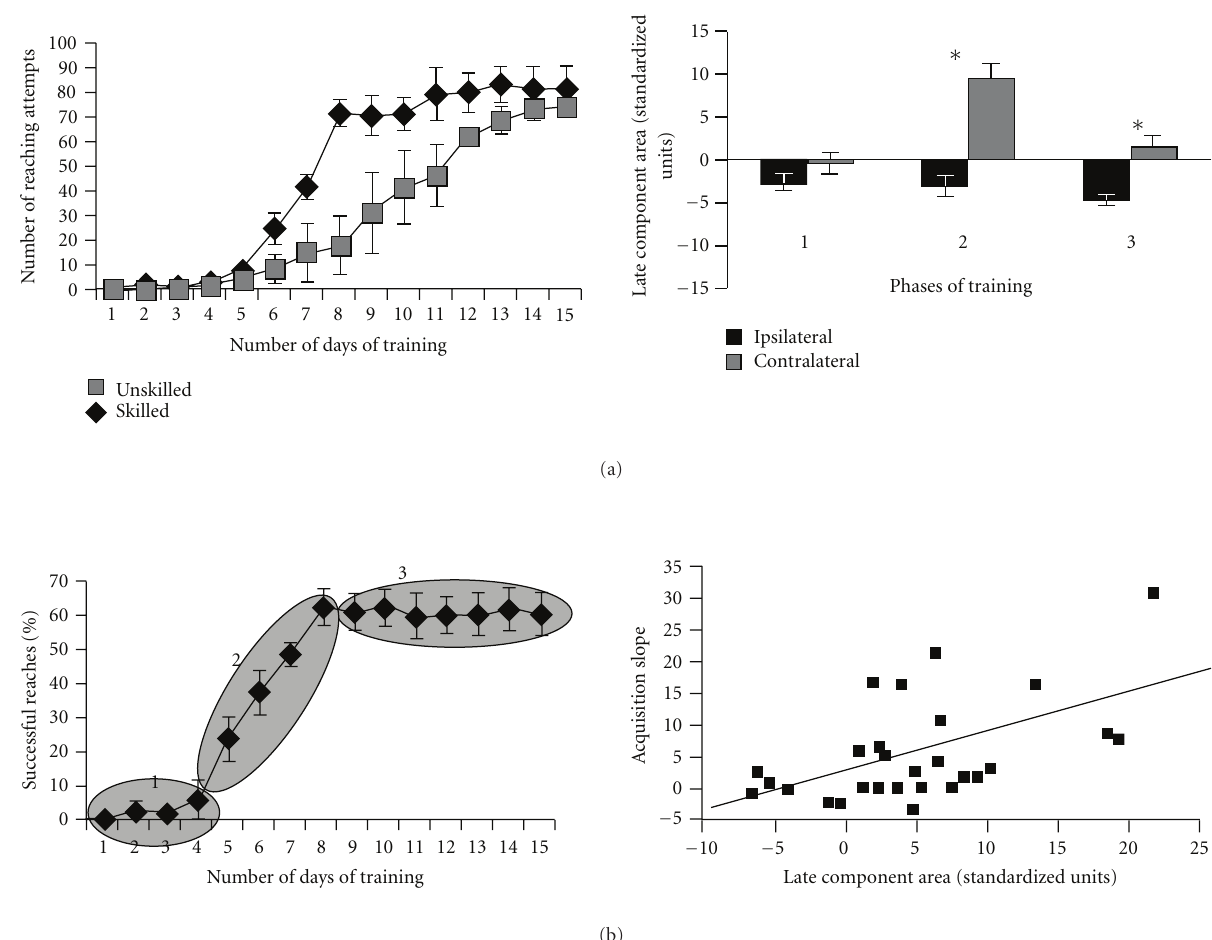
Figure 3: Taken from [50] with permission. The upper left panel shows the number of reaching attempts made on the RGR task over days between the skilled and the unskilled reaching groups, with the associated learning curve for the skilled group shown below it. The upper right panel shows the related changes in the late phase of the evoked field potential over the three phase of learning. Note the linear relation- ship between the learning curves acquisition slope on the y -axis of the bottom right panel and the area under the late phase field